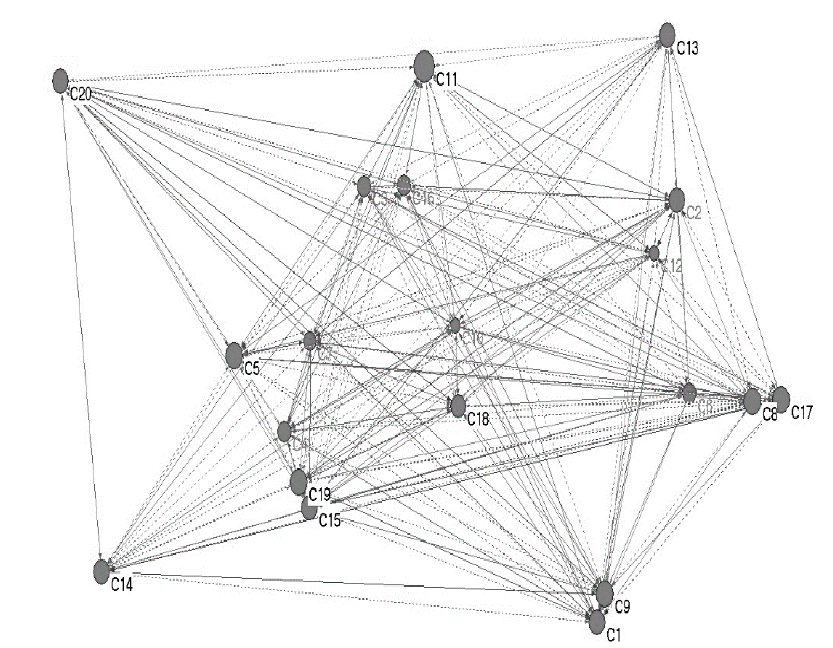
Fig. 3. Graphic visualization of the practices for implementation CMS: Solid arrows represent positive relationships and line segment arrows represent negative